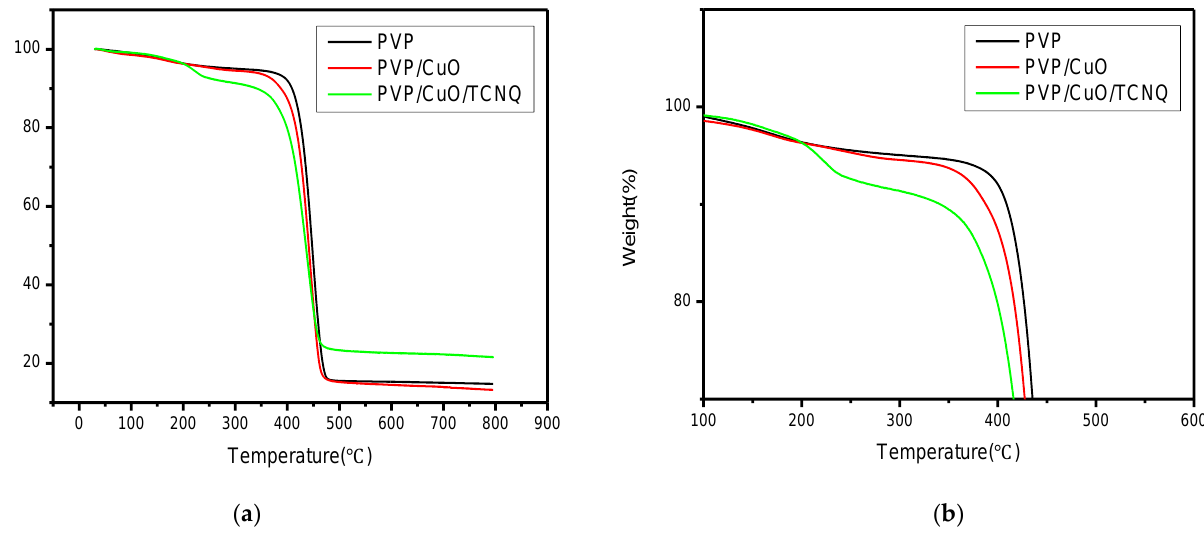
Figure 4. ( a ) TGA curves of PVP/CuO and PVP/CuO/TCNQ composites, and ( b ) enlarged image of ( a ) from 100 to 600 °C.